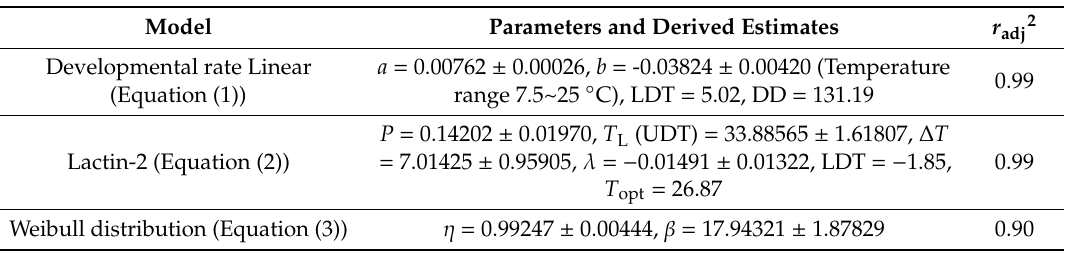
Table 3. Parameters and values derived from the development rate models and the distribution model for A. solani nymphs in Figure 1.